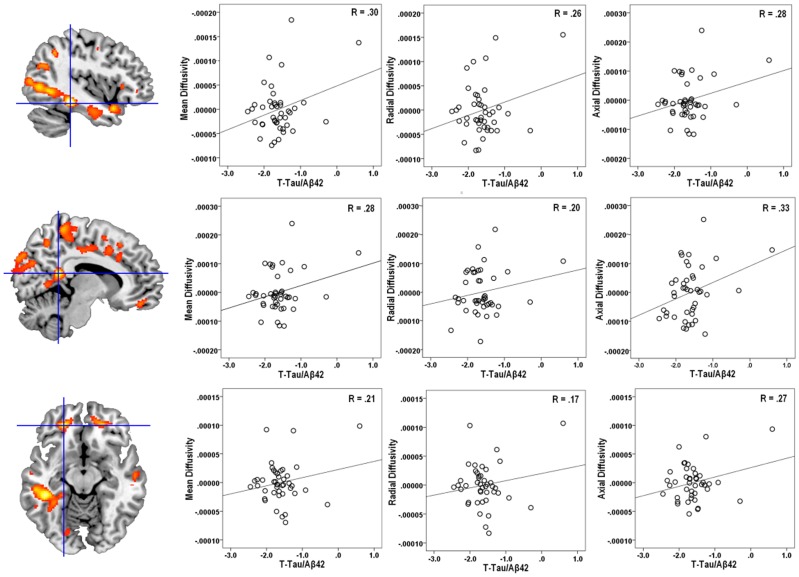
T-Tau/Aβ42 Plotted against mean, radial, and axial diffusivity.Shown here are the results of the voxel-wise analysis, where regions with color overlay are those where higher T-Tau/Aβ42 was associated with higher diffusivity (mean, radial, and axial). In order to illustrate the relationship between T-Tau/Aβ42 and the diffusivity maps, we extracted diffusion values from representative regions of significant correlation in the voxel-wise analysis and plotted them against T-Tau/Aβ42. Shown on the top row are diffusion values extracted from the left temporal lobe (x = −42, y = −34, z = −16) plotted against T-Tau/Aβ42. In the middle row are diffusion values extracted from right posterior cingulum bundle (x = 8, y = −46, z = 16) plotted against T-Tau/Aβ42. In the bottom row are diffusion values extracted from left inferior frontal white matter (x = −22, y = 43, z = −12) plotted against T-Tau/Aβ42. Blue crosshairs overlaid on the brain sections indicate the location of the extracted values. Each point in the scatter represents diffusion values from one participant (n = 43). T-Tau/Aβ42 values were log-transformed and mean, radial, and axial diffusivity values were adjusted for age at time of scan, sex, and treatment (CSF data were collected at baseline in a Simvastatin treatment trial, data from the prevention trial are not shown here).